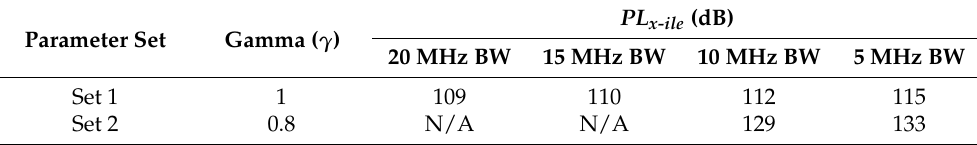
Table 8. Power control parameter